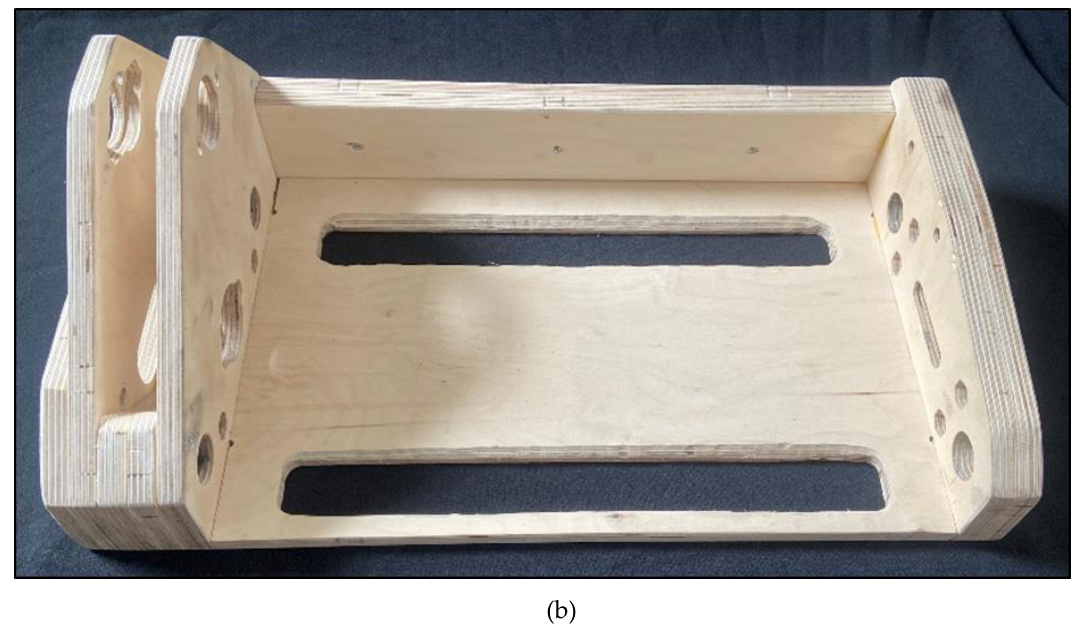
Figure 1. ( a ) CAD with dimensions of plywood frame and ( b ) image of completely assembled frame.